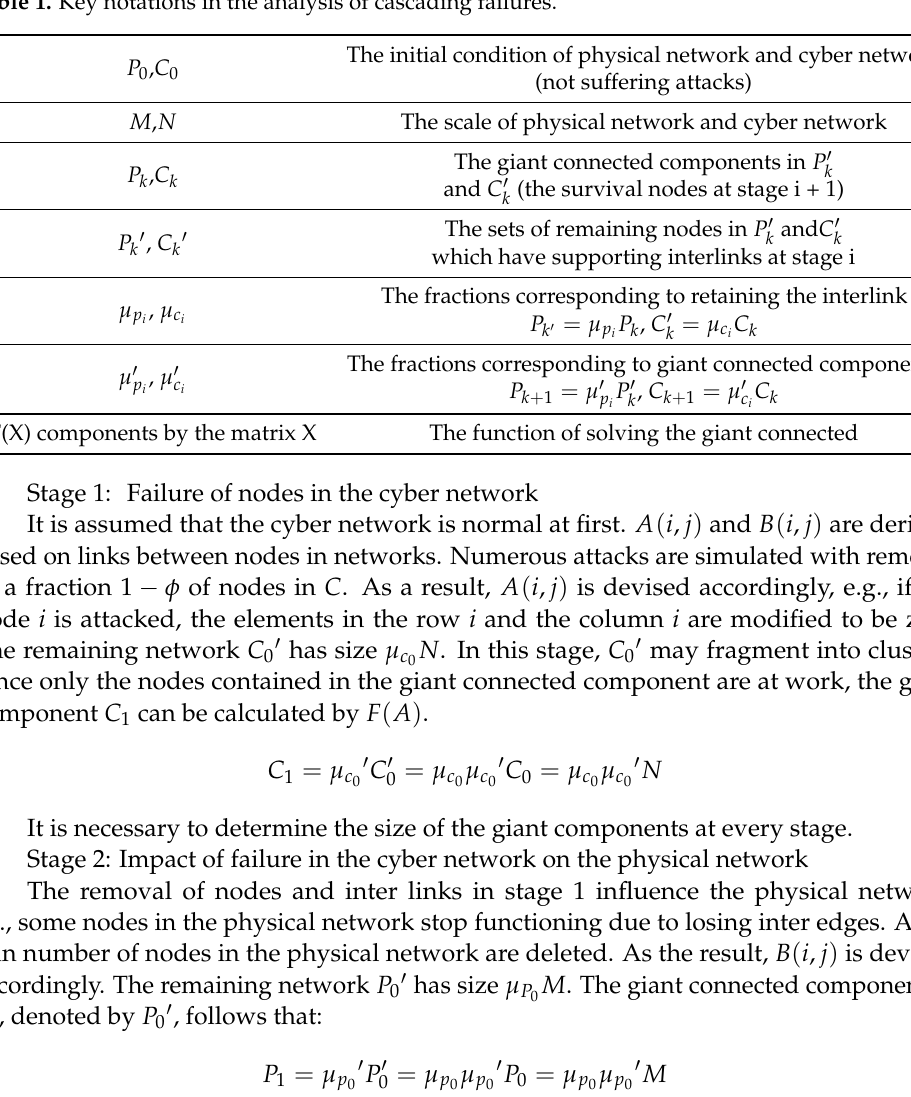
Table 1. Key notations in the analysis of cascading